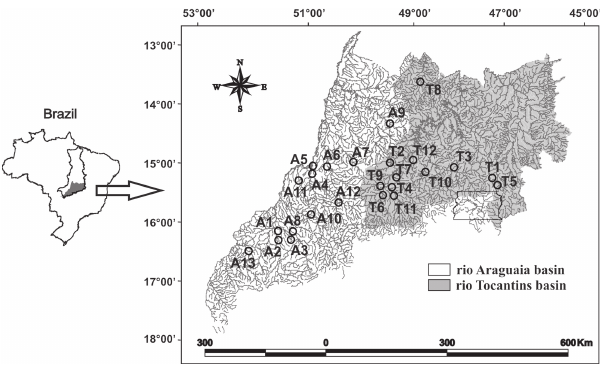
Fig. 1. Locality of streams sampled in the Araguaia (A1- A13) and Tocantins (T1-T12) river basins, Central Brazil. Tocantins-Araguaia basin is represented in the small map of